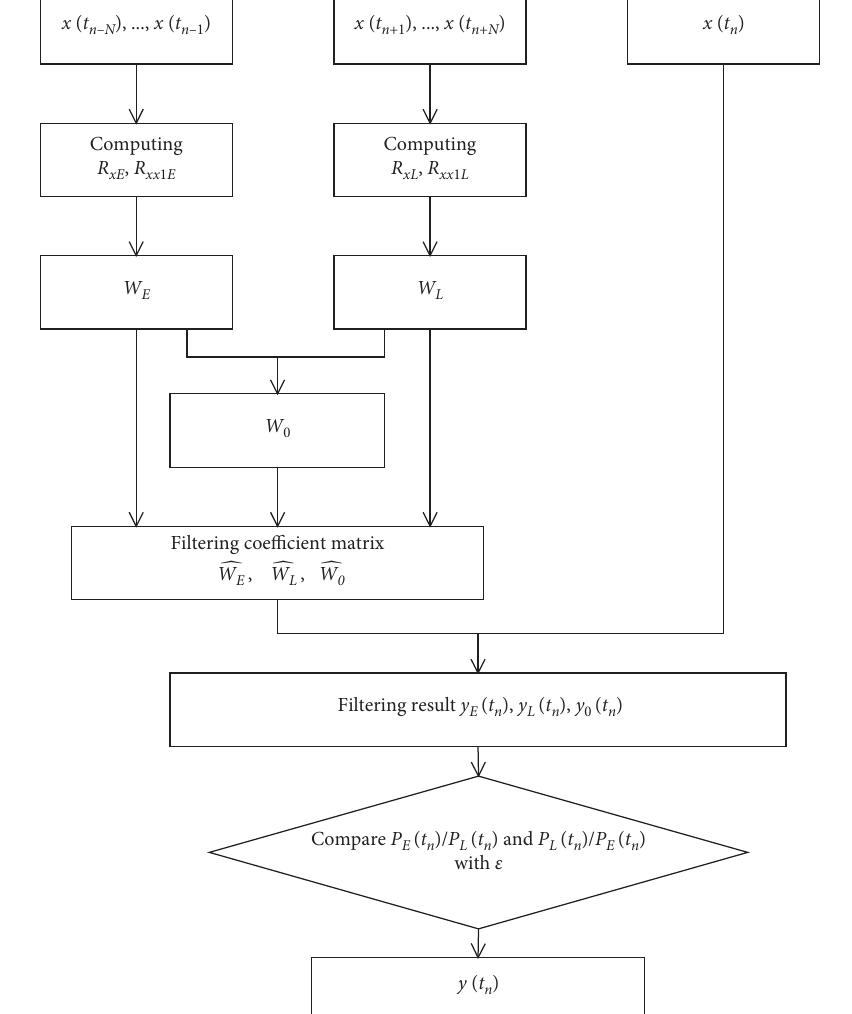
Figure 3: Flow chart of the adaptive filtering method.